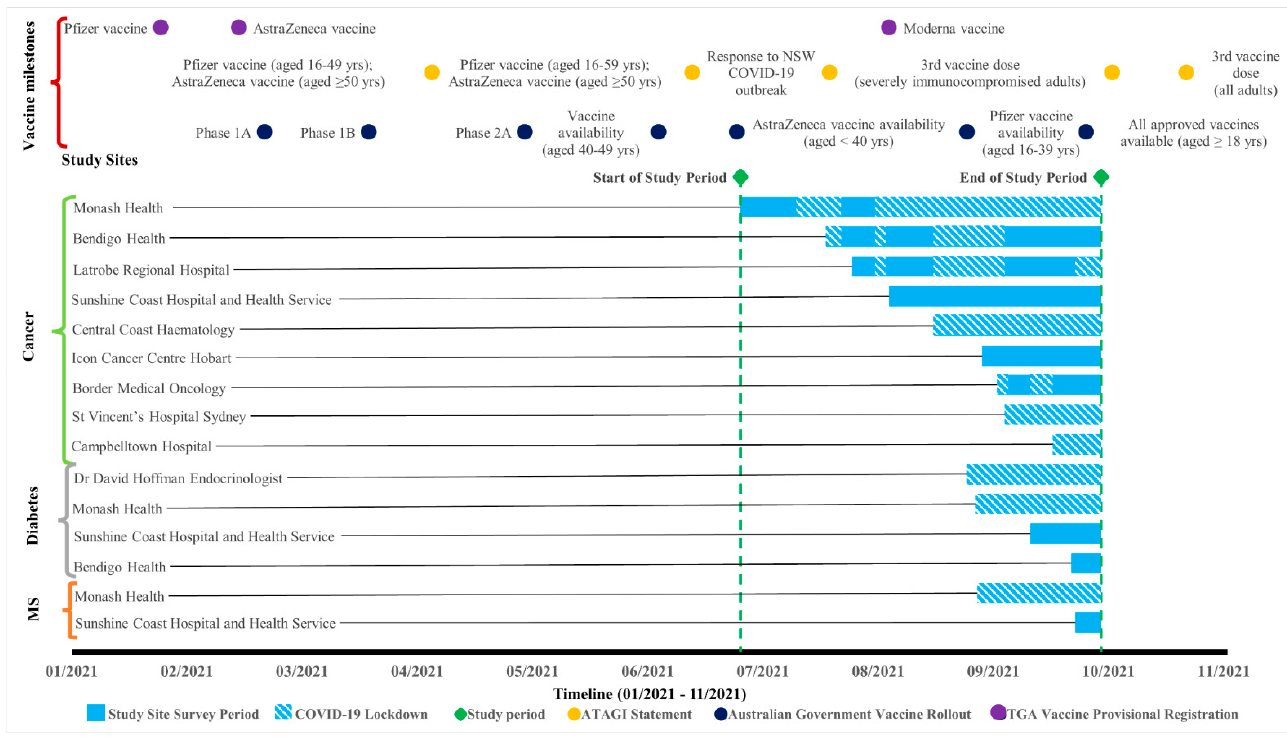
Figure 1. Survey timeline for each health service and participant group, with Australian State Government COVID-19 lockdowns embedded in the study site survey period. Abbreviations: Yrs, years; MS, multiple sclerosis; ATAGI, Australian Technical Advisory Group on Immunisation; TGA, Therapeutic Goods Administration. Australian Government Vaccine Rollout Phase population group eligibility: Phase 1A rollout = Quarantine and border workers, health care workers, aged and disability residents and staff; Phase 1B rollout = Adults aged 70 years and over, Aboriginal and Torres Strait Islander people aged 55 years and over, Adults with underlying medical conditions, other critical and high ‐ risk workers; Phase 2A rollout = Adults aged 50 years and over, Aboriginal and Torres Strait Islander people aged 18 years and over.